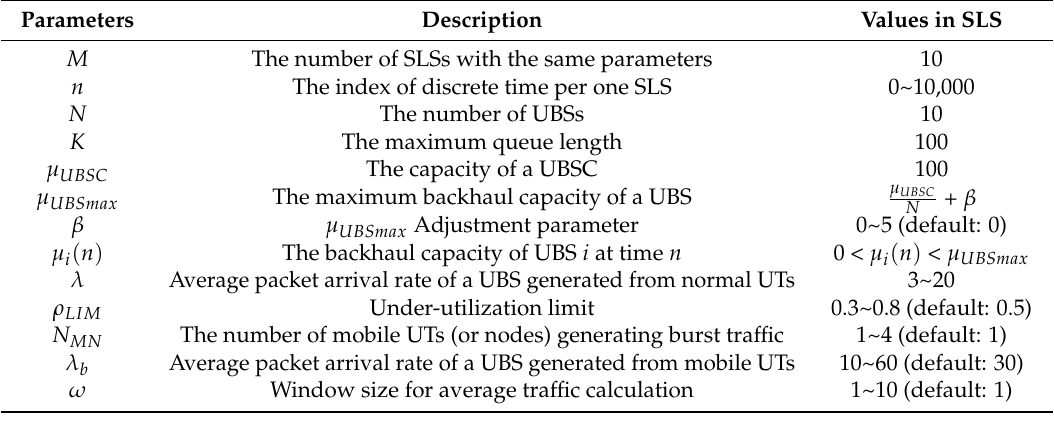
Table 3. Parameters used in the System Level Simulations.